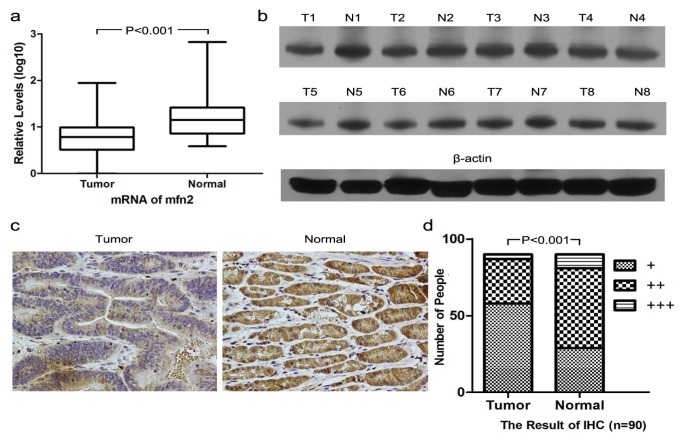
Mfn2 expression was confirmed higher in normal mucosal tissue than in tumor tissue by three methods, including (a) QRT-PCR (n = 30), (b) Western blot (n = 20, only showing eight pairs) and (d) IHC (n = 90). Representative IHC staining of Mfn2 in tumor tissue and normal mucosa tissue is shown in (c) (200×).